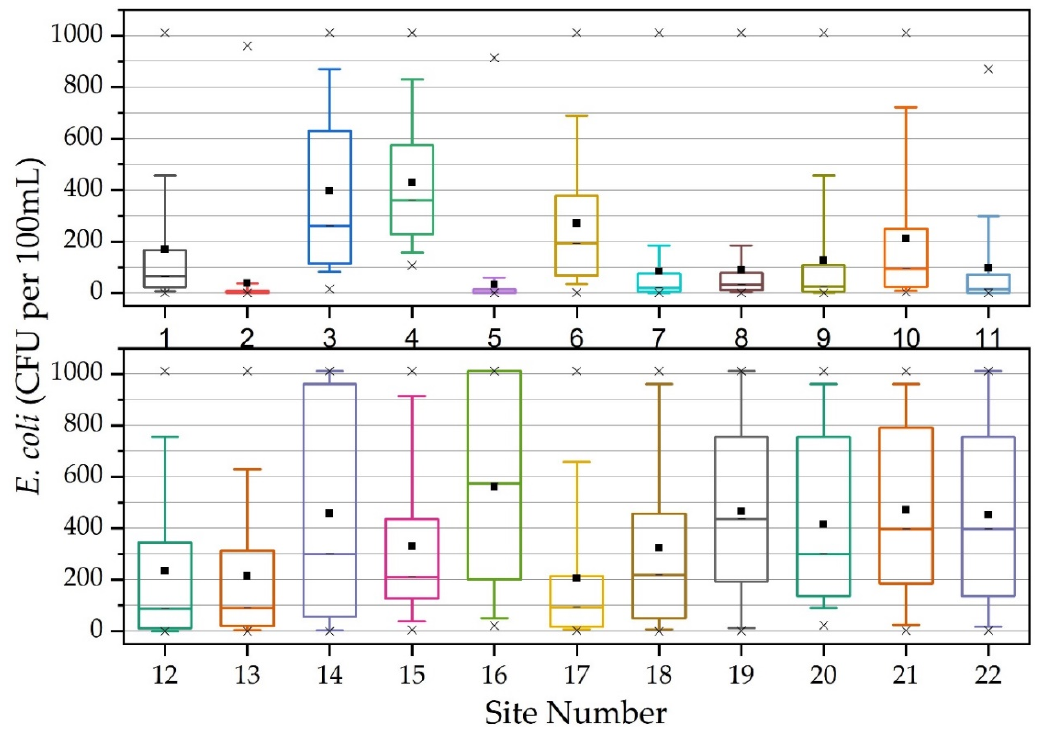
Figure 4. Box and whisker plot of E. coli concentration (CFU per 100 mL) at each sampling location (n = 22) during the study period (2 January 2018–1 January 2019) in West Run Watershed, Morgantown, West Virginia, USA. Boxes delineate 25th and 75th percentiles; lines denote medians; squares show means; whiskers describe 10th and 90th percentiles; x shows maxima and minima when above and below, respectively. Note: different box colors represent data from different sites.